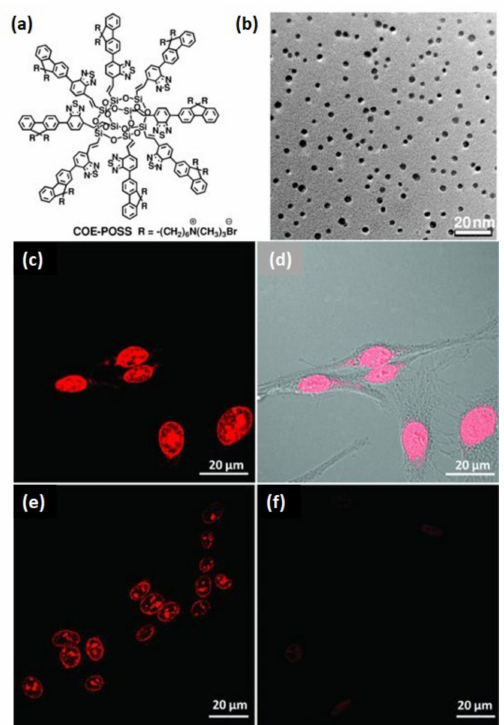
Figure 9. ( a )Chemicalstructureand( b )HR-TEMimageofCOE-POSS.( c )OPEFand( d )OPEF/transmission overlapped images of MCF-cells stained with 1 µ M COE-POSS. The signals are collected above 560 nm upon excitation at 488 nm. TPEF images of MCF-7 cells incubated with 1 µ M COE-POSS ( e ) or SG ( f ) for 2 h. Reprinted with permission from ref. [62]. Copyright 2010 John Wiley and Sons.